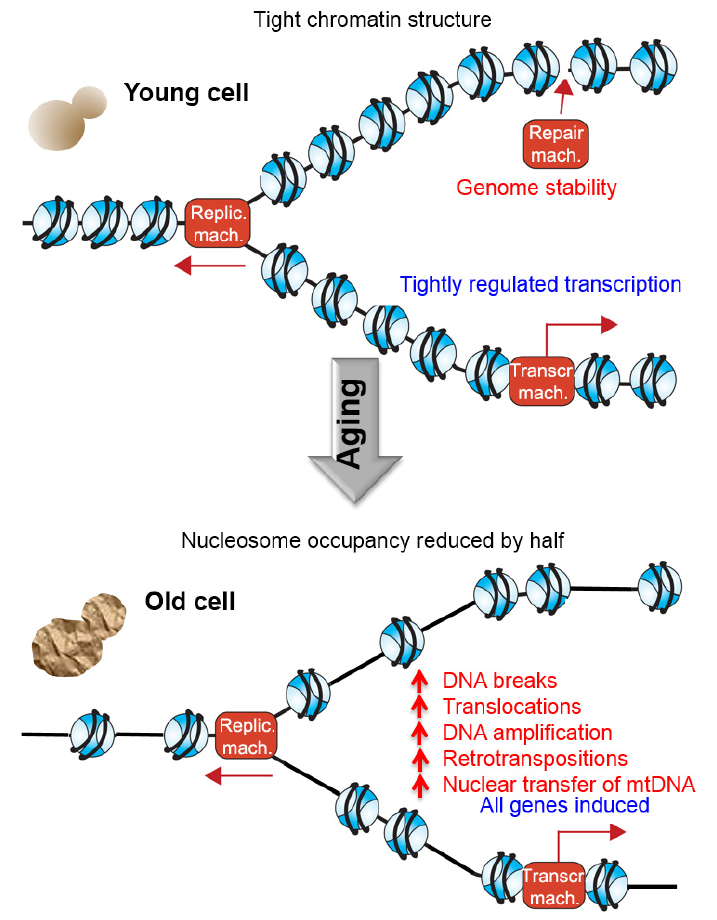
FIGURE 1: Summary of our findings. During replicative aging of budding yeast, there is a loss of half of the nu- cleosomes over the genome, leading to increased tran- scription from all genes in the genome, increased amounts of DNA breaks, translocations, amplifications, retrotransposition and transfer of mtDNA to the nucleus. Replic. mach., replication machinery; Repair mach., re- pair machinery; Transcr. mach., transcription